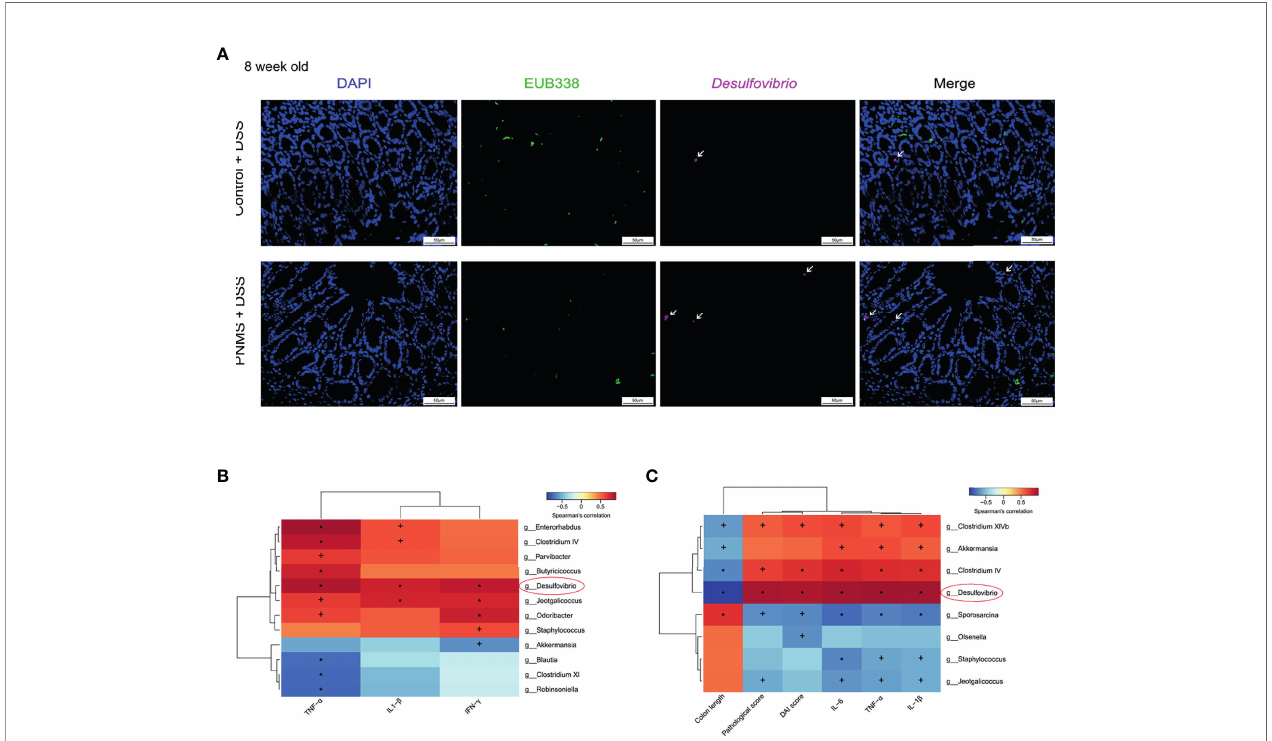
FIGURE 8 | The relative abundance of Desulfovibrio increased in PNMS offspring mice and was associated with intestinal in fl ammation. (A) Fluorescence in situ hybridization (FISH) detection of Desulfovibrio in colon tissues in 8-week-old colitis model offspring. A fl uorescein isothiocyanate (FITC)-conjugated universal bacterial 16S rDNA-directed oligonucleotide probe (EUB338, green ) and a Cy5-conjugated Desulfovibri o speci fi c probe ( red ) were applied. (B, C) Heatmap of Spearman ’ s correlations between the differential bacteria and markers of intestinal in fl ammation in 3- and 8-week-old offspring. DSS , dextran sulfate sodium; PNMS , prenatal maternal stress. Scale bar , 50 m m. Magni fi cation, ×400. + p < 0.05, * p < 0.01 (Spearman ’ s